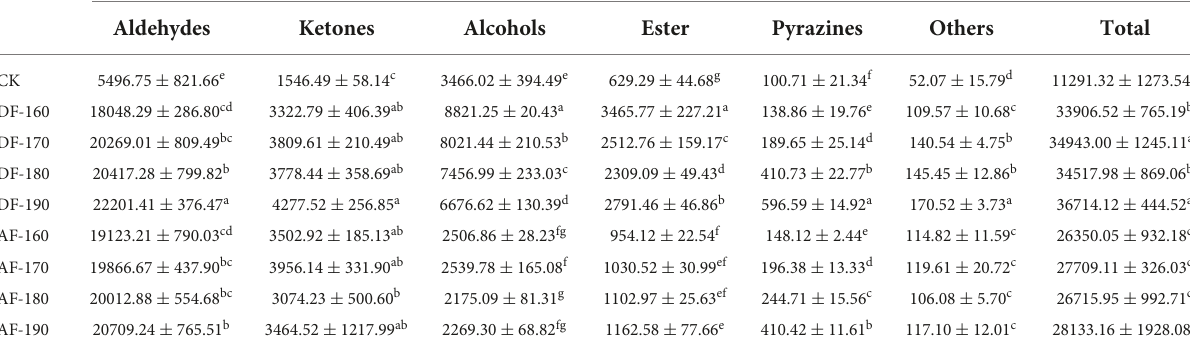
TABLE 3 Types and peak areas of volatile flavor compounds in fried crayfish shrimp meat. Group Volatile flavor compounds (Peak volume) Aldehydes Ketones Alcohols Ester Pyrazines Others